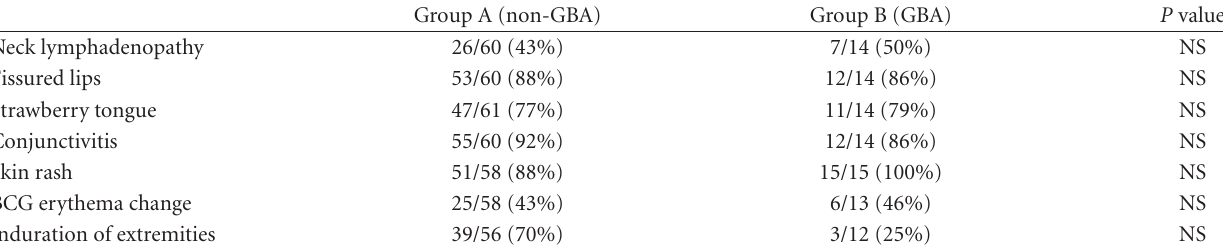
Table 2: Principal clinical features in the acute stage of Kawasaki disease between gallbladder abnormalities (GBAs) and non-GBA groups. Group A (non-GBA)